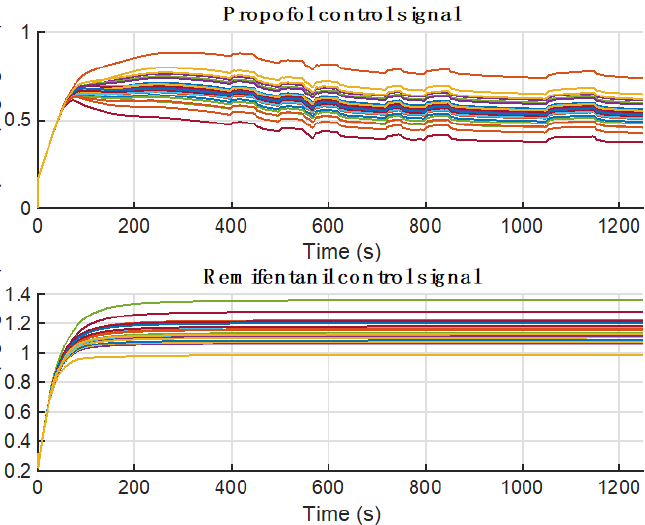
Figure 5. Induction-phase propofol and remifentanil control signals—simulation results for 24 pa- tients.